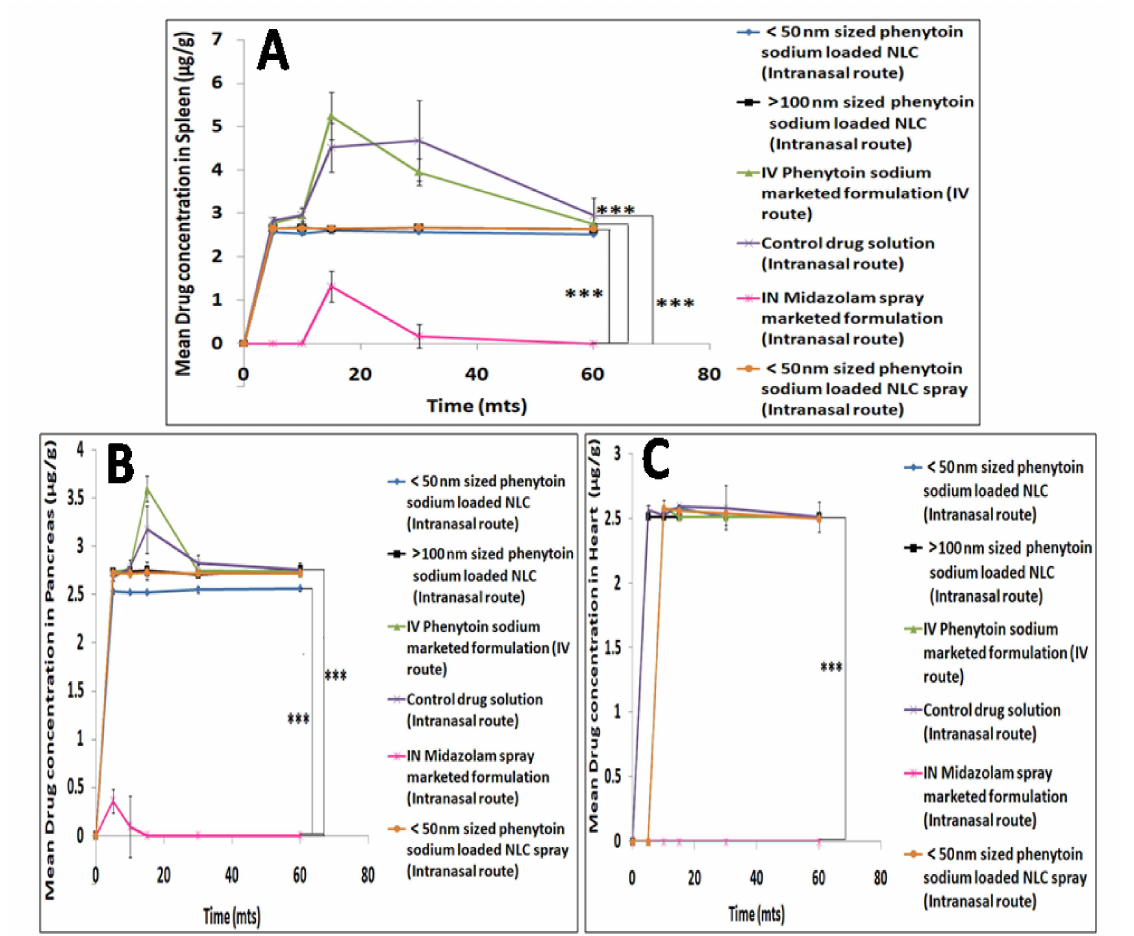
Figure 9. Mean spleen ( A ), pancreas ( B ) and heart ( C ) drug concentration profiles following intranasal administration of phenytoin sodium NLCs, control drug solution, midazolam marketed formulation and IV administration of phenytoin sodium marketed formulation. The level of statistical significance is expressed as a p -value; *** indicates p <